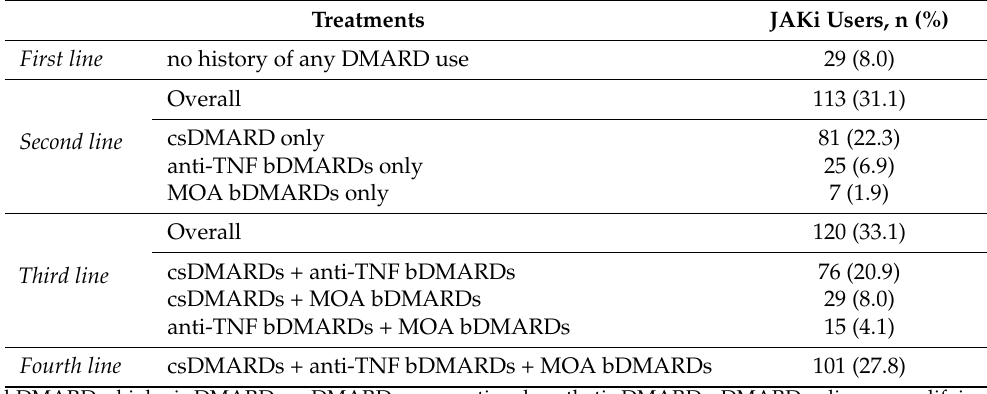
Table 2. Description of the previous treatment lines of the incident JAKi users (n =